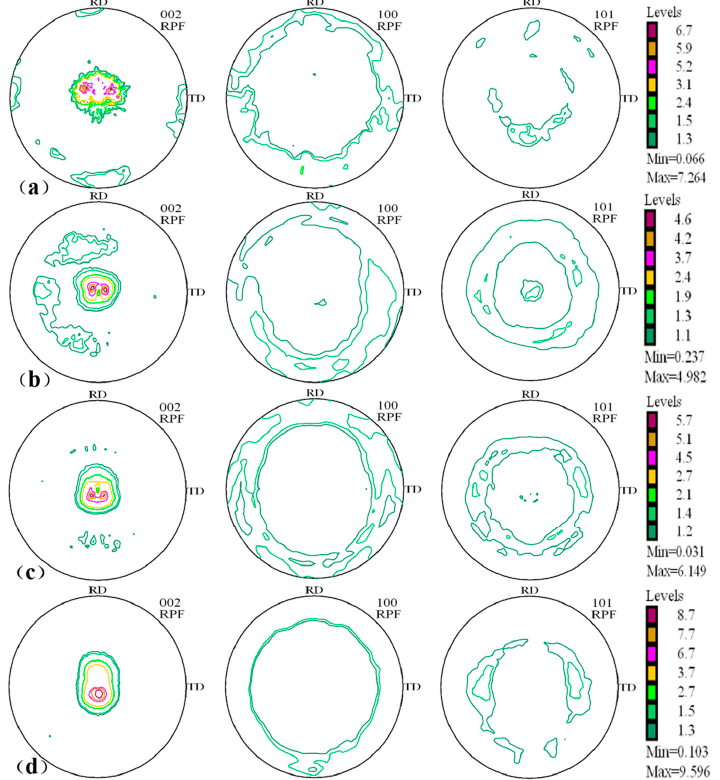
Figure 8. The pole figures of AT11M alloy sheets: ( a ) as-extruded, ( b ) rolled at 150 °C, ( c ) rolled at 200 °C, and ( d ) rolled at 250 °C.